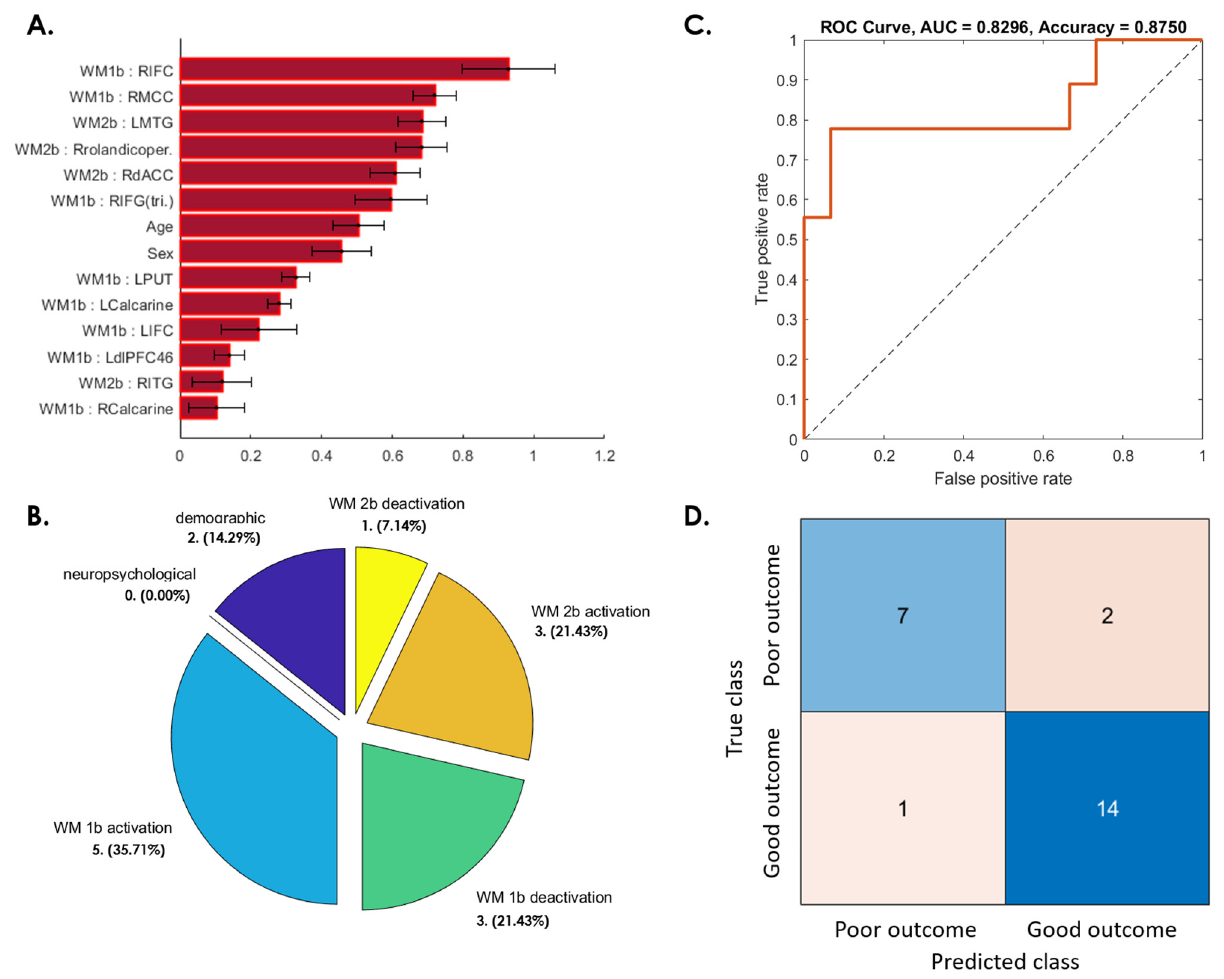
Figure 3. SVM predictive model for 37.5% of patients whose WM ability did not recover at the 3-month follow-up. ( A ) The red bar graph and the corresponding error bar, respectively, represent the average and standard deviation of the discriminative feature weights among the 10 cross-validated SVM classifiers. ( B ) Profiles of selected features for constructing the SVM classification model. None of the neuropsychological features were selected for this predictive model. ( C ) ROC curve of the selected feature to differentiate the “poor outcome group” from the “good outcome